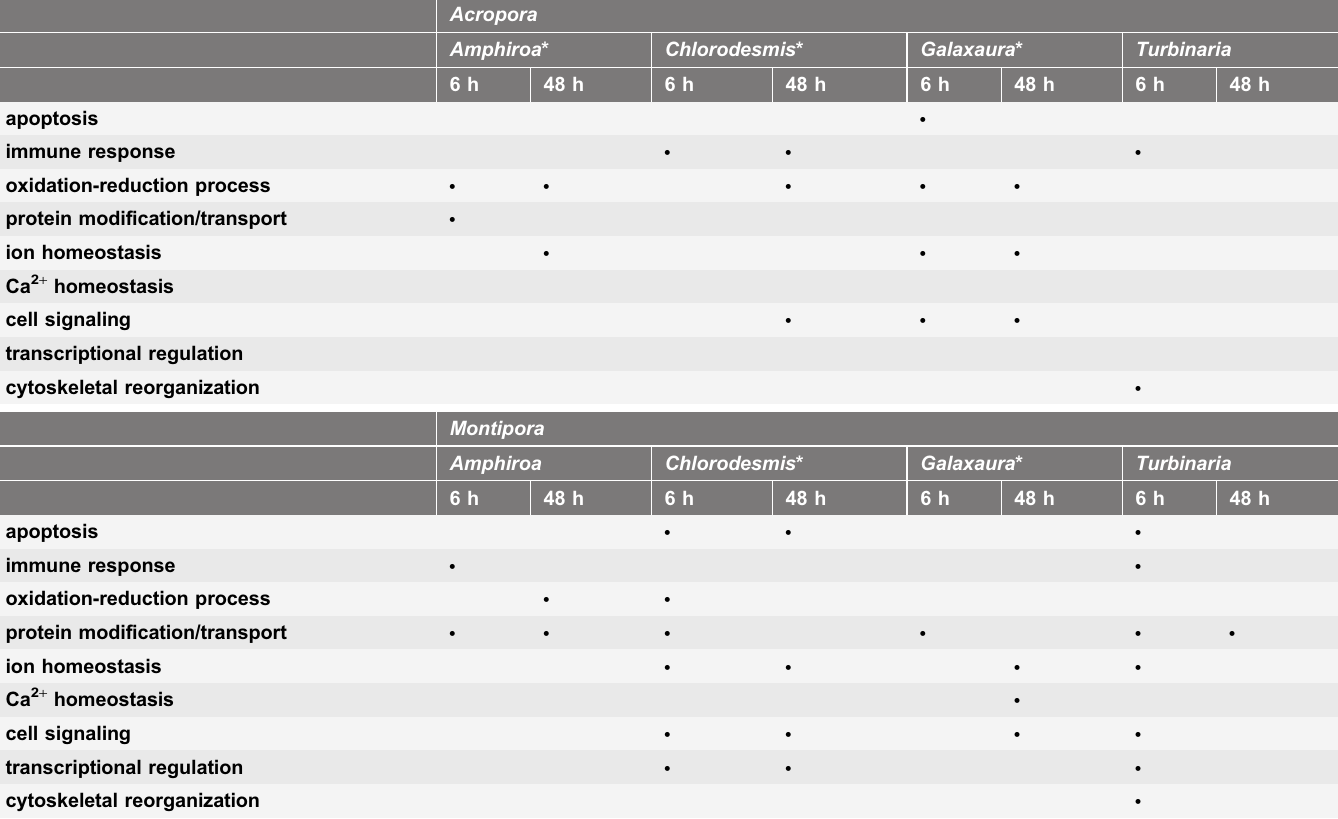
Dots indicate an over-representation of biological processes and molecular functions of differentially expressed genes within these general response categories for each macroalgal treatment. Asterisks denote macroalgae that caused physiological damage (bleaching, mortality and reductions in photosynthetic activity of Symbiodinium ) to the coral holobiont after 20d of contact